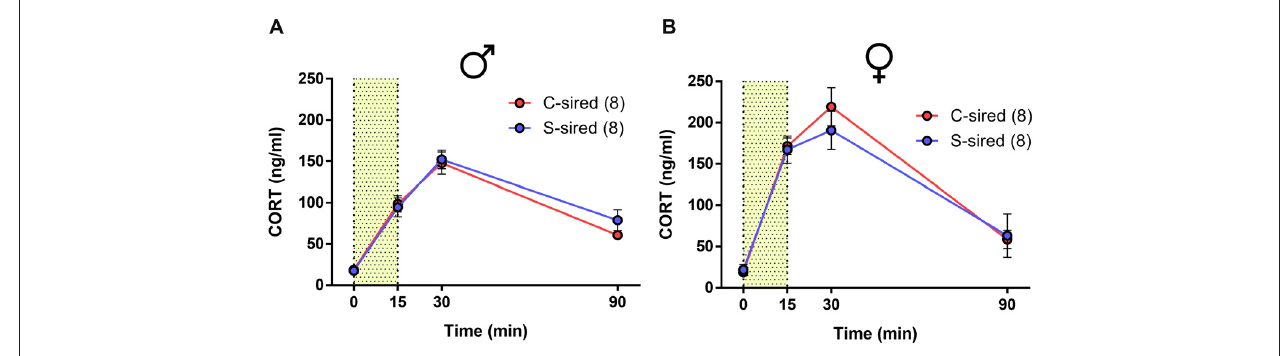
Frontiers in Behavioral Neuroscience |